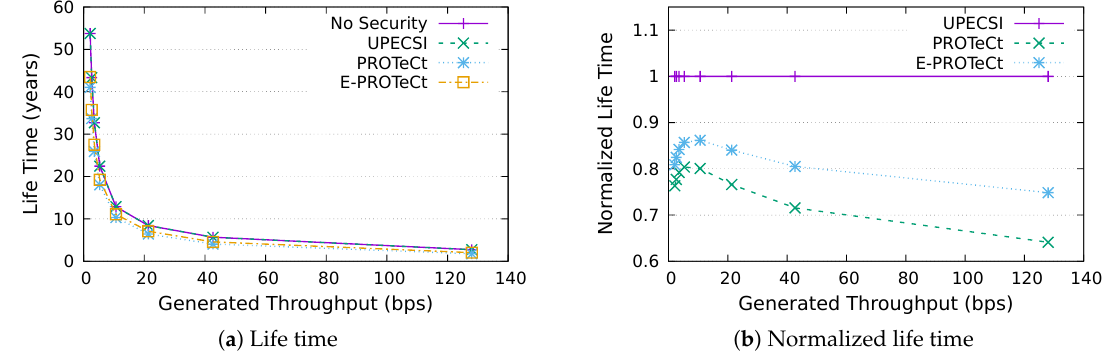
Figure 19. Life time analysis for an IoT network with eight